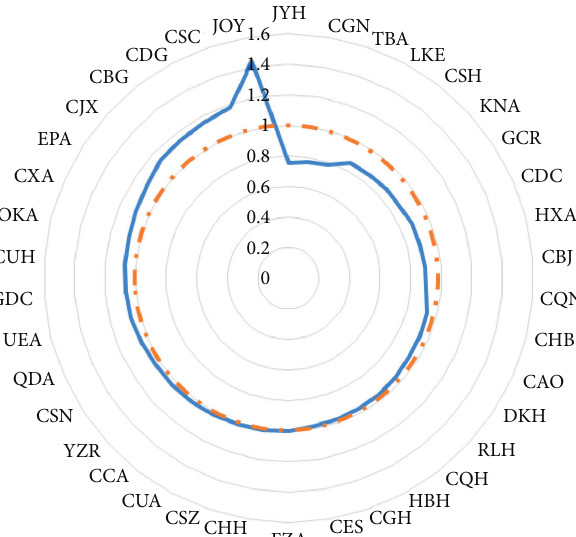
Figure 9: Fairness metric values of airlines with the reliability range of 60%–75%. Figure 10: Fairness metric values of airlines with the reliability range of